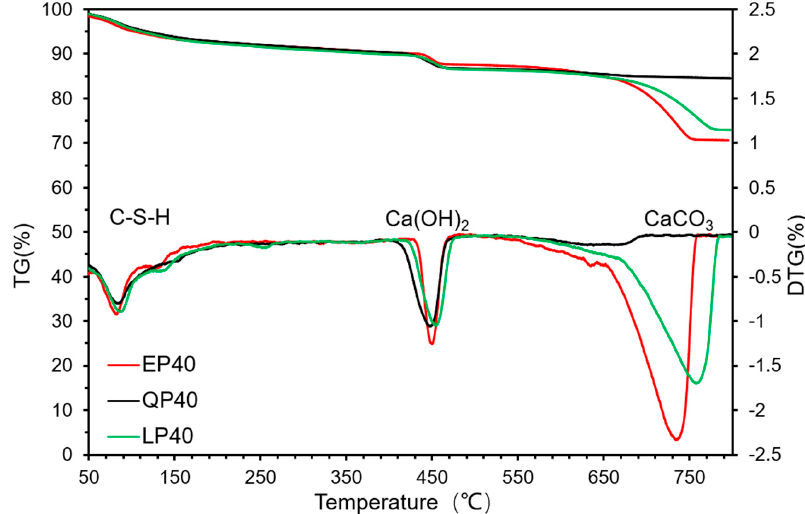
Figure 14. Thermal decomposition of EP40, QP40 and LP40 by TGA–DTG analyses at 7 d.